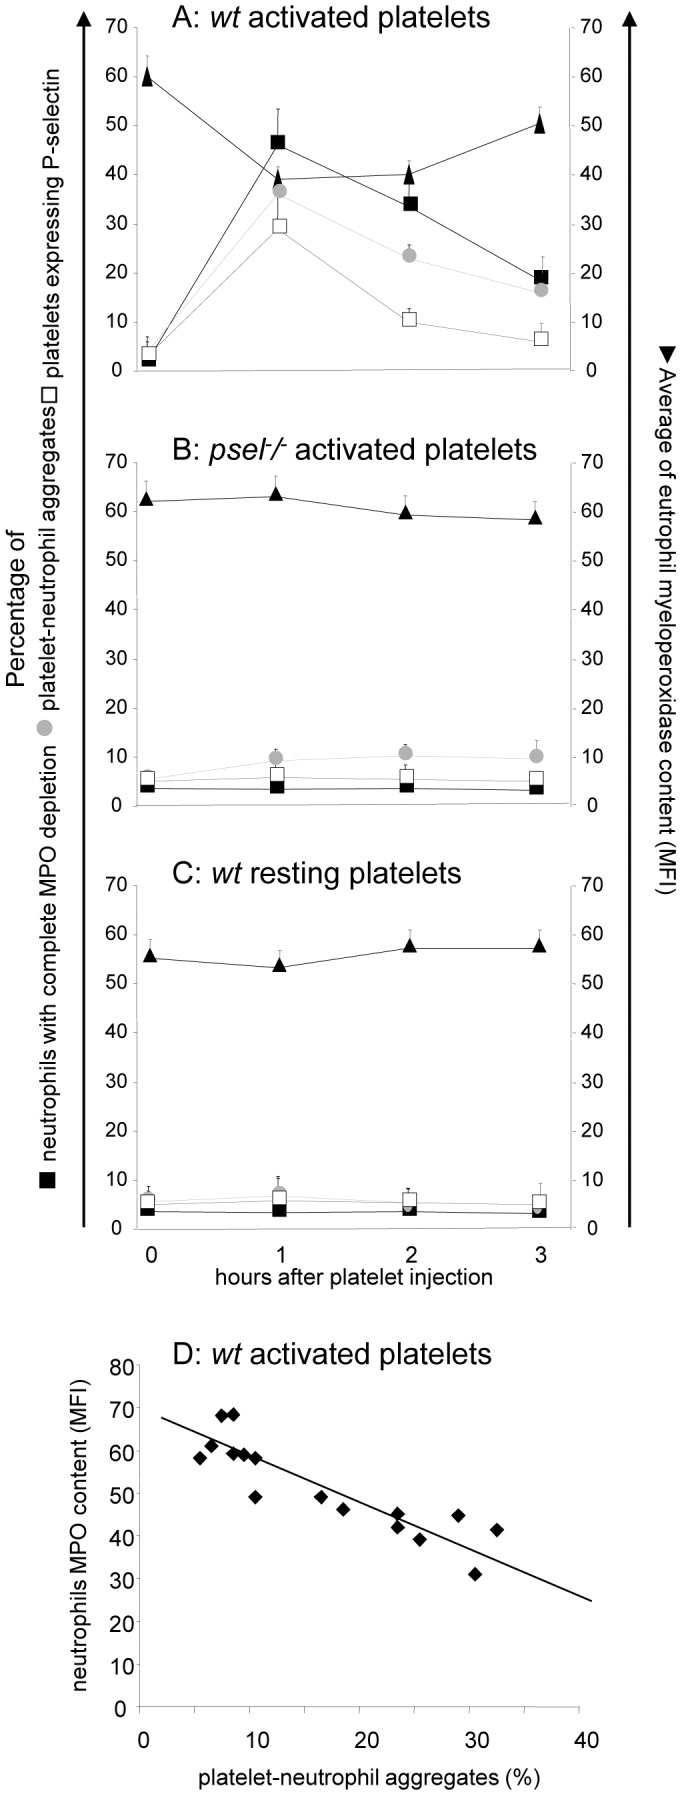
In vivo evidence that circulating activated platelets cause neutrophil degranulation.Purified platelets from wild type or Psel −/− mice were activated (or not) and injected in the tail vein of wild type C57BL/6 mice. Platelet activation was achieved with thrombin. The molecule was then inactivated by addition of hyrudin. Neutrophil myeloperoxidase content, platelet P-selectin expression and platelet-neutrophil heterotypic aggregates were assessed by flow cytometry as described in the Methods. Panel A shows the effect of the in vivo injection of the buffer used for platelet activation, containing both thrombin and hyrudin. Blood was retrieved at different times after injection (hours, x axis) and neutrophils with adherent (filled symbols) or internalized (grey symbols) platelets were identified by flow cytometry. >70% of circulating neutrophils were engaged in the internalization and adhesion of activated, but not resting, platelets after 1 hour. The fraction of circulating neutrophils with internalized and adherent platelets returned to background levels 24 hours after the injection. Results are expressed as mean±S.E.M. 5–7 animals were assessed per each point.